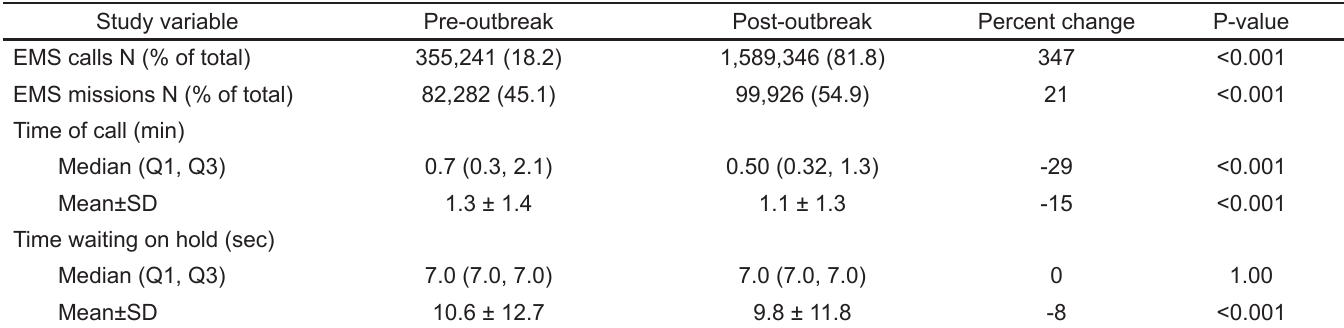
Table 1. Emergency medical services dispatches and calls before and after the beginning of the COVID-19 outbreak.